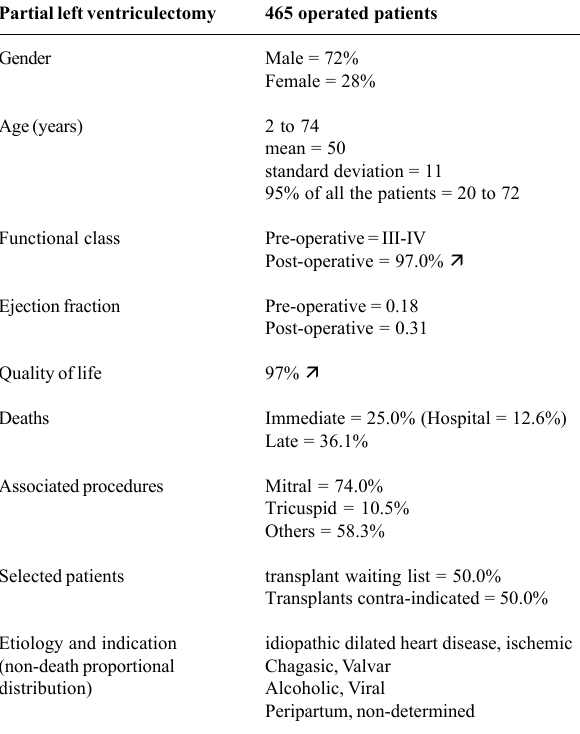
Table 1. Partial left ventriculectomy: Clinical data